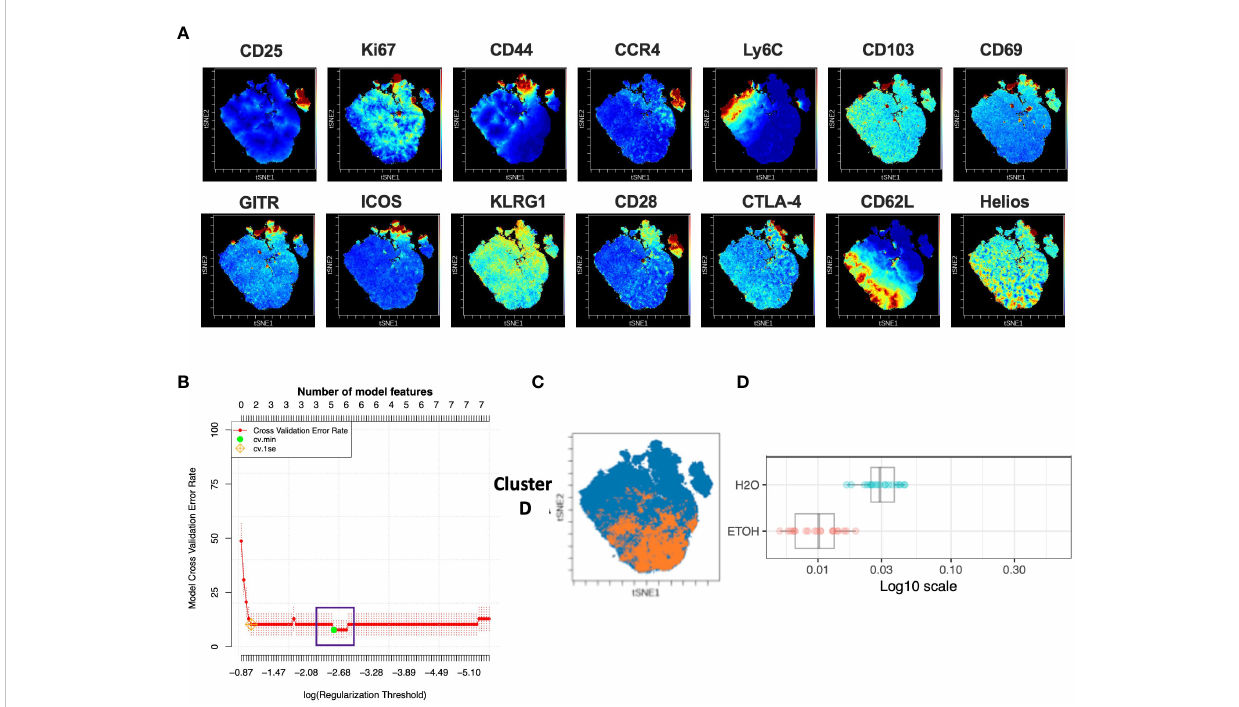
FIGURE 4 Combined CITRUS and viSNE analysis revealed one CD4 + T Conv cluster associated with alcohol-drinking mice. (A) CD4 + T Conv subset samples from the modeling cohort were equally downsampled to 20000 events to detect 2% subpopulations with CV=5%. 1 water drinking sample was excluded due to insuf fi cient event count. viSNE mapping was performed using all 14 available markers for clustering (CD3, CD4, CD8 and Foxp3 were excluded). Iterations were set to 7500, perplexity 70 and theta 0.5. This process was repeated to create two total viSNE maps, one of which was concatenated and displayed above. (B) CITRUS analyses was performed on the events comprising each viSNE plot. Samples were grouped by alcohol versus water exposure, the same 14 channels used for viSNE were selected for clustering by abundance. LASSO modeling was selected, minimum cluster size was set to 2%, false discovery rate 1% (note: this is irrelevant for LASSO), cross validation folds 10, and scales were normalized. The CV.MIN output was selected from the LASSO analysis. This process was repeated 3 times for each of the two viSNE maps yielding 6 total CITRUS replicates. A representative model error rate plot is show. (C) 6 CITRUS replicates were compared using the “ clusters-cv_min ” output fi le histograms. 1 cluster predictive of alcohol versus water drinkers was present across all replicates Cluster (D) and was selected for downstream analyses. Representative clusters from one CITRUS run were concatenated and individually overlaid onto their corresponding viSNE plot shown in (A) . (D) Representative CITRUS feature plot corresponding to (C) showing differences in cluster frequency between alcohol and water exposed